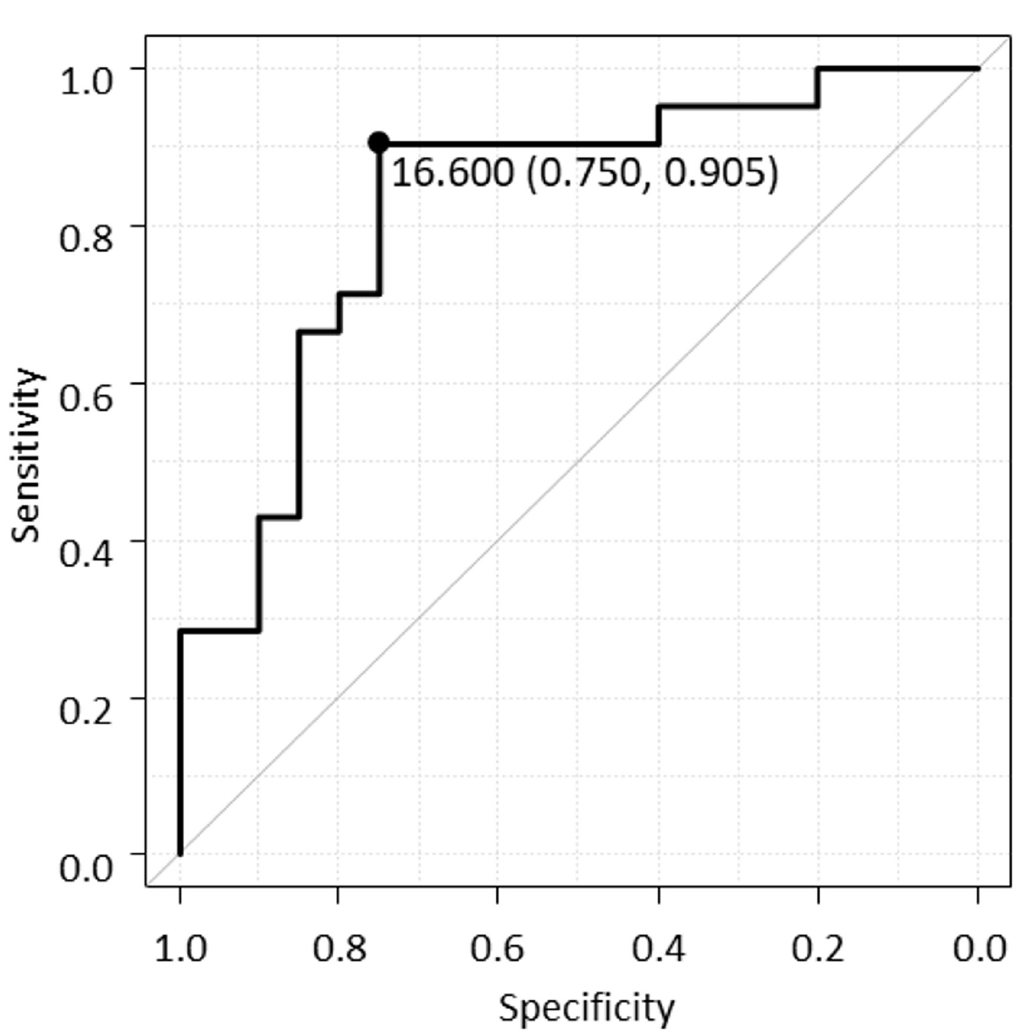
Fig 1. Receiver operating characteristic (ROC) curve of NTx for predicting the Z score decrease for 2 years. ROC analysis indicates an optimal cut-off value of NTx predicting Z score decrease is 16.6 nmol BCE/L, and the area under the curve is 0.826 (95% confidence interval